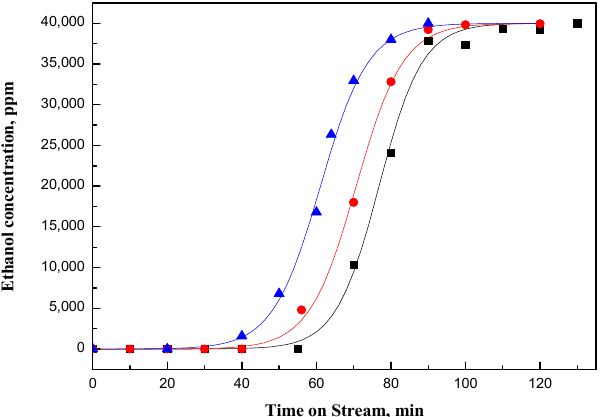
Figure 1. Breakthrough curves of ethanol for fresh NaY-SiO 2 ( ■ ), NaYR (HF) ( • ), and NaYR (LF) ( ▲ ); the